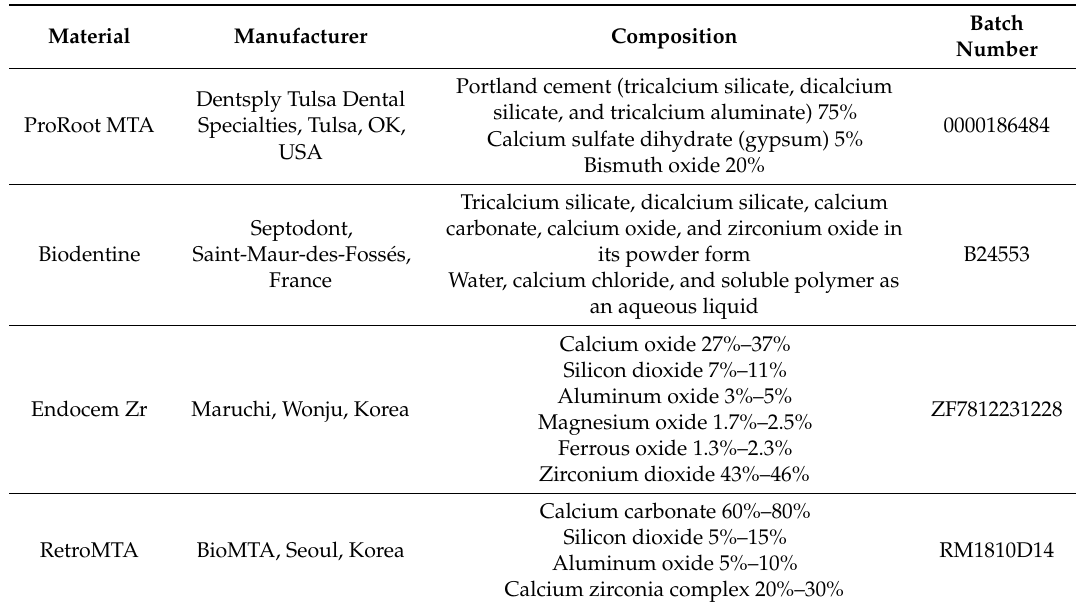
Table 1. The manufacturer and chemical composition of each experimental calcium silicate-based cement used in this study